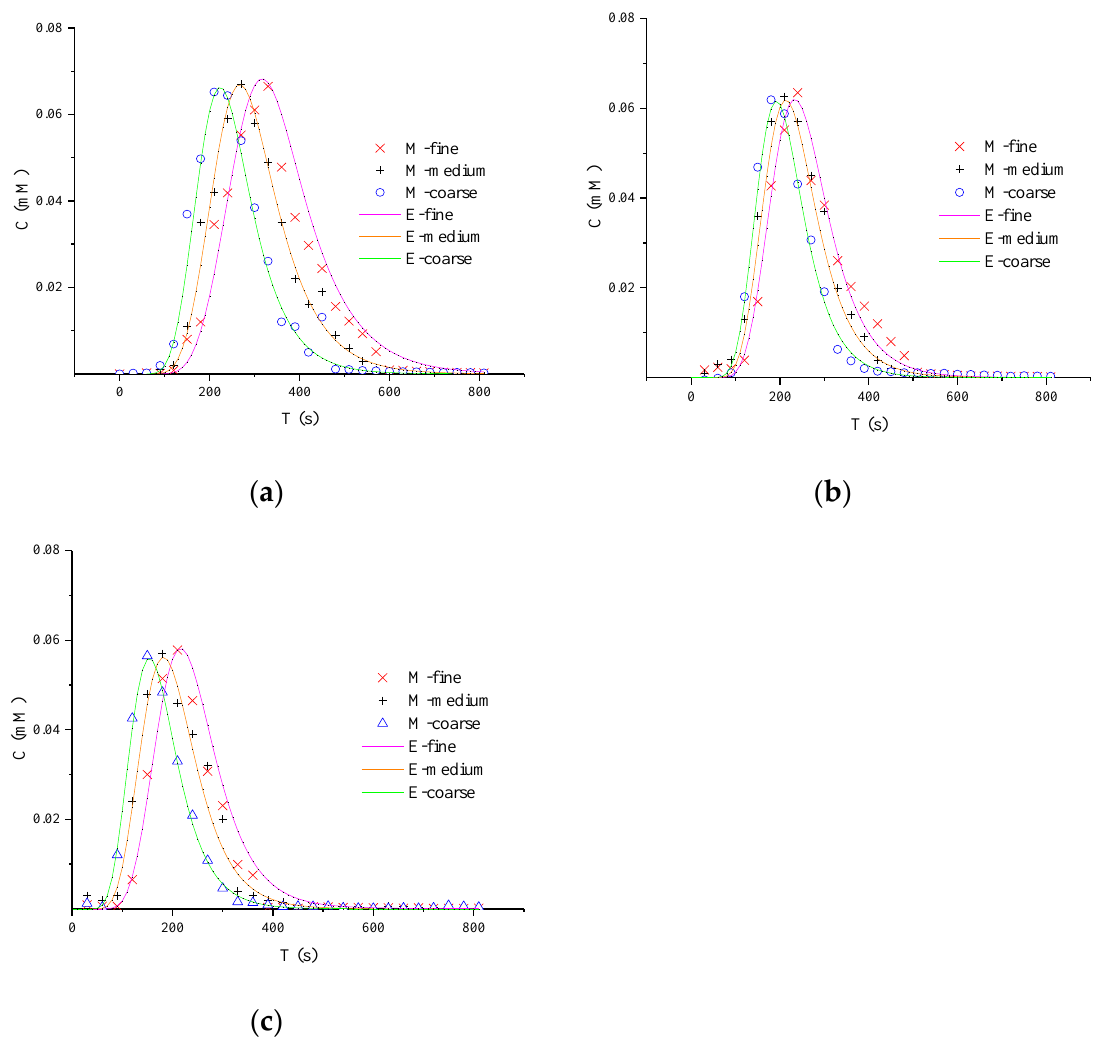
Figure 2. Breakthrough curves of product NQAB under different media particle sizes: ( a ) refers to 40.063 ml/min; ( b ) refers to 60.094 mL/min; ( c ) refers to 80.126 mL/min (M is the measured concentration and E is the predicted concentration). Table 2. Fitting parameters of CTRW-FEM for reactive migration in porous media. Flow Rate (mL/min)